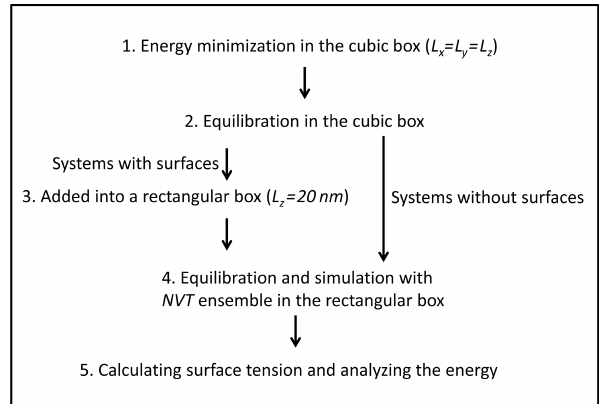
Figure 2. Schematic diagram of the different steps performed in the MD